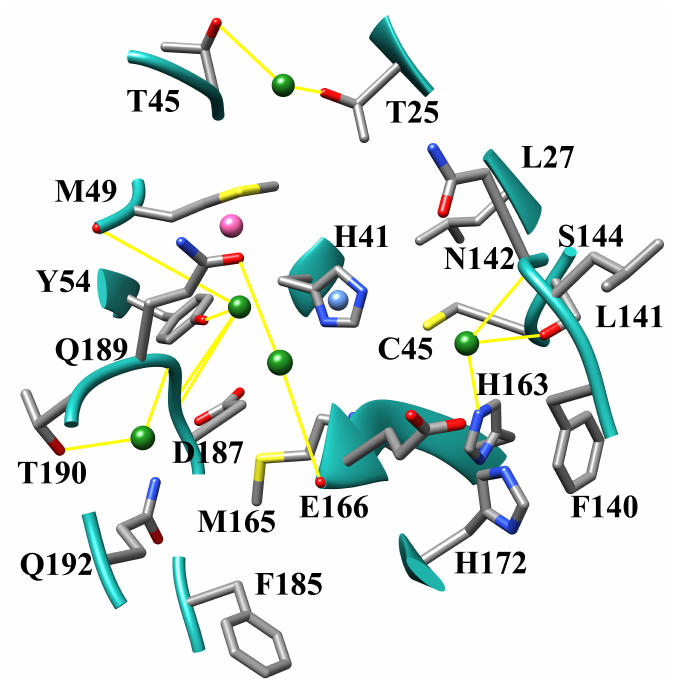
Figure 22. Visual summary of key molecular interactions facilitating strong binding a ffi nity to SARS-CoV-2 M pro . Hydrogen bond hotspots are shown as green spheres, with hydrogen bonds shown as yellow lines. The hydrophobic core in S2 pocket is indicated by pink sphere. Blue sphere indicates π - π stacking